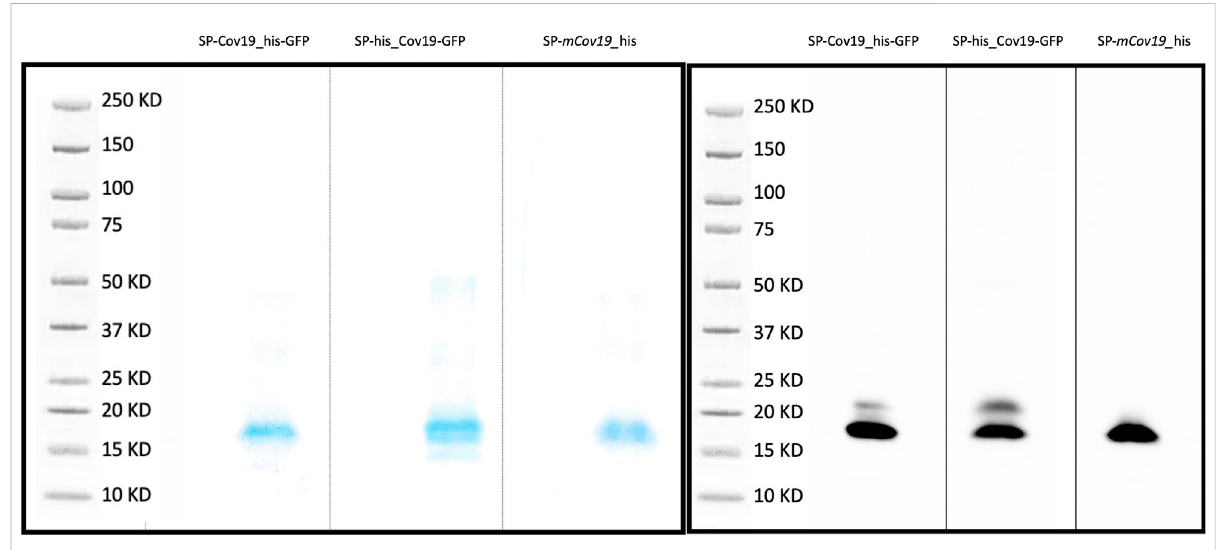
SDSPAGEandWesternblot. (A) Coomassiebluestainwasusedtoverifypurityofconcentratedproteinsandbandsize. (B) Westernblottingwas carried out to detect the target puri fi ed SP-CoV19_his-GFP, SP-his_CoV19-GFP and negative control SP-mCov19_his using his antibodies.